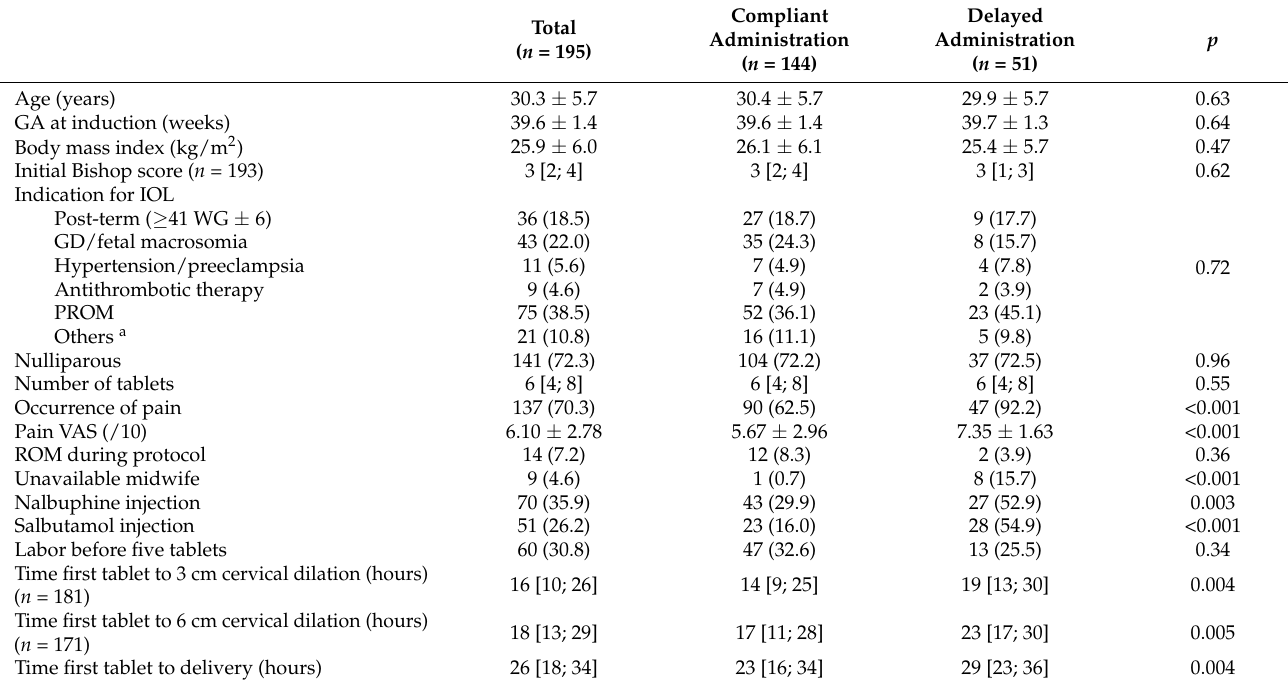
Table 2. Factors associated with protocol